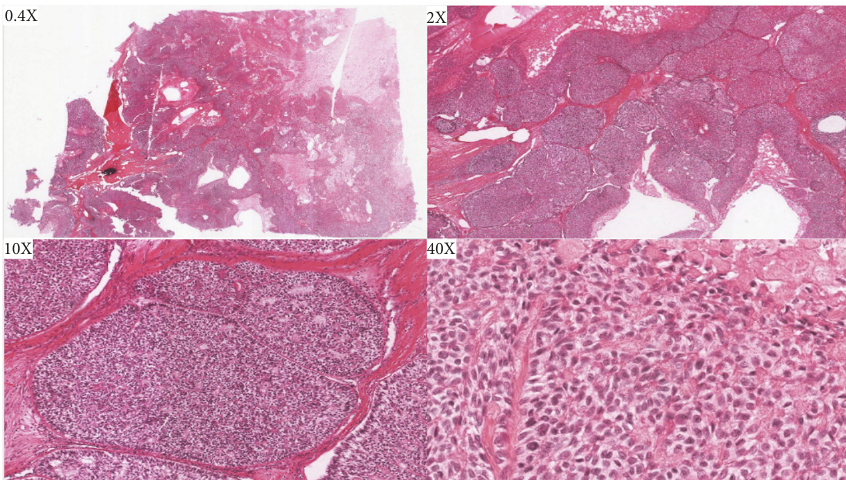
Figure3:Representativeimagesoforalmucosawithchangesconsistentwithamalignantglandularepitheliumneoplasm.Theneoplasticclear cells were arranged in nests, cords, and anastomosing trabeculae embedded in hyalinized, acellular, predominantly basophilic stroma. The tumor demonstrated a nodular infiltrative growth pattern, lacked overt ductal differentiation, and showed several areas of necrosis, including nests with comedo type necrosis.